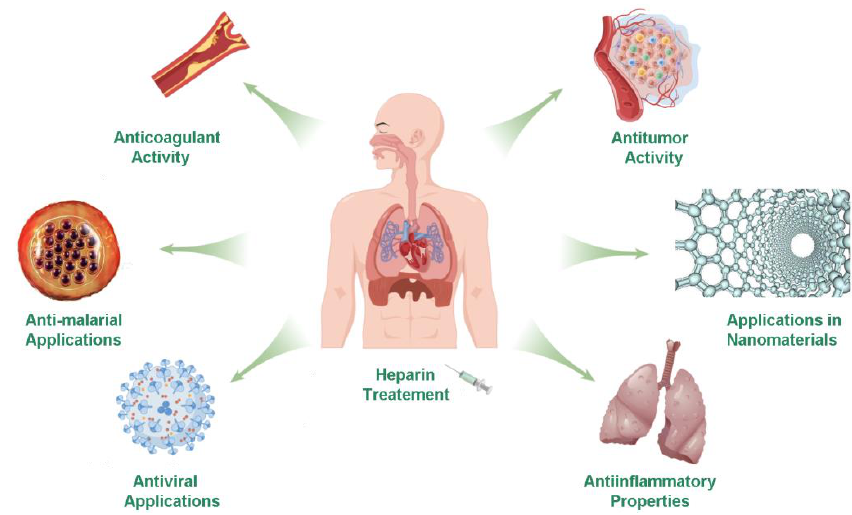
Figure 1. The applications of heparin.